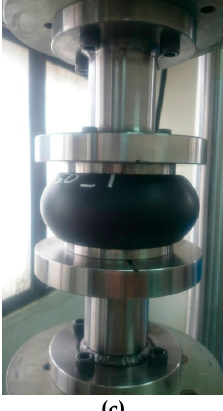
Figure 1. ( a ) Geometry and dimensions of tested rubber fender, ( b ) time history of cyclic strain signal, and ( c ) illustration of tested rubber fender at strain of − 0.5 under monotonic compression.